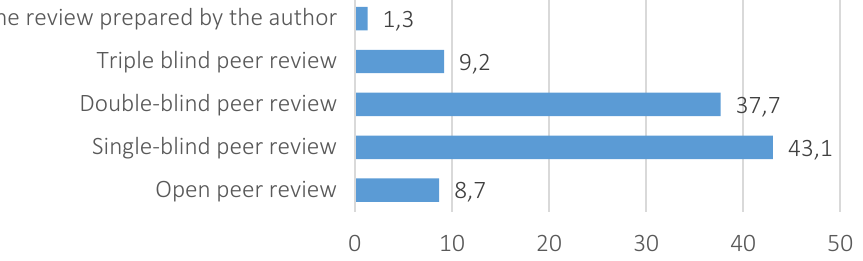
Figure 2. Distribution of answers to the question “What model of review do you prefer?”, %